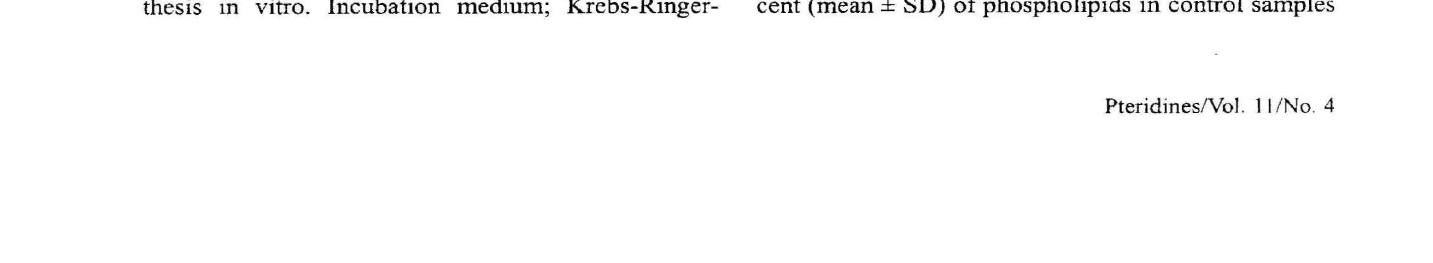
Fig.10. Concentrations (mean ± SD) of cholesterol and phospholipids, as well as fatty acid content in per cent (mean ± SD) of phospholipids in control samples (open bars) and in samples with 4 runo! noradrenalinlg wet weight (hatched bars). Samples of rat liver tissue homogenate were used to test for phospholipid biosyn thesis in vitro. Incubation medium; Krebs-Ringer-